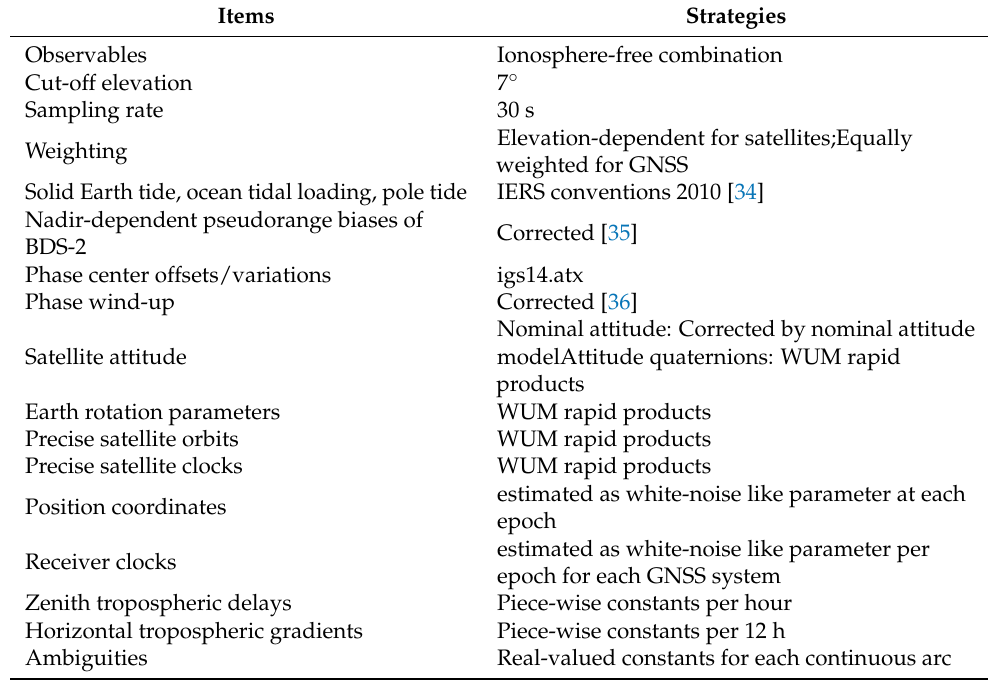
Figure 1. Distribution of used IGS stations. 184 stations (red dots) are used for integer clock products computation and 490 stations (blue dots) are used for PPP-AR experiments. Table 1. Processing strategies of